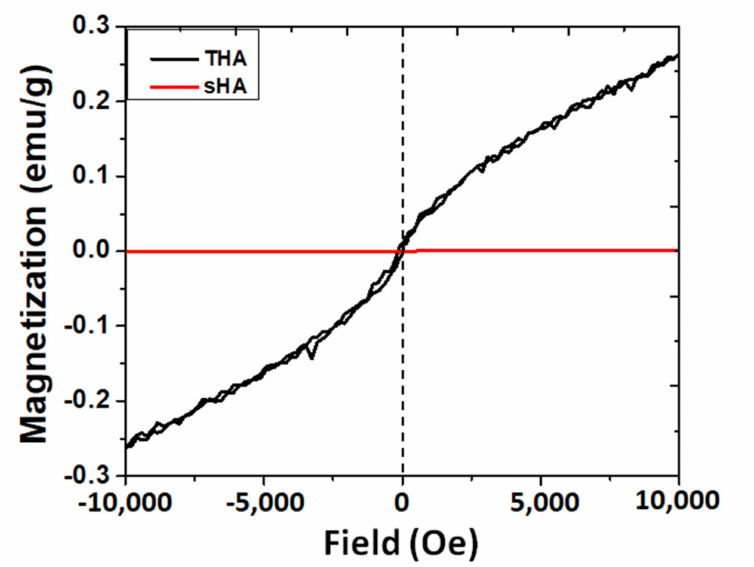
Figure 3. Magnetization dependence on magnetic field